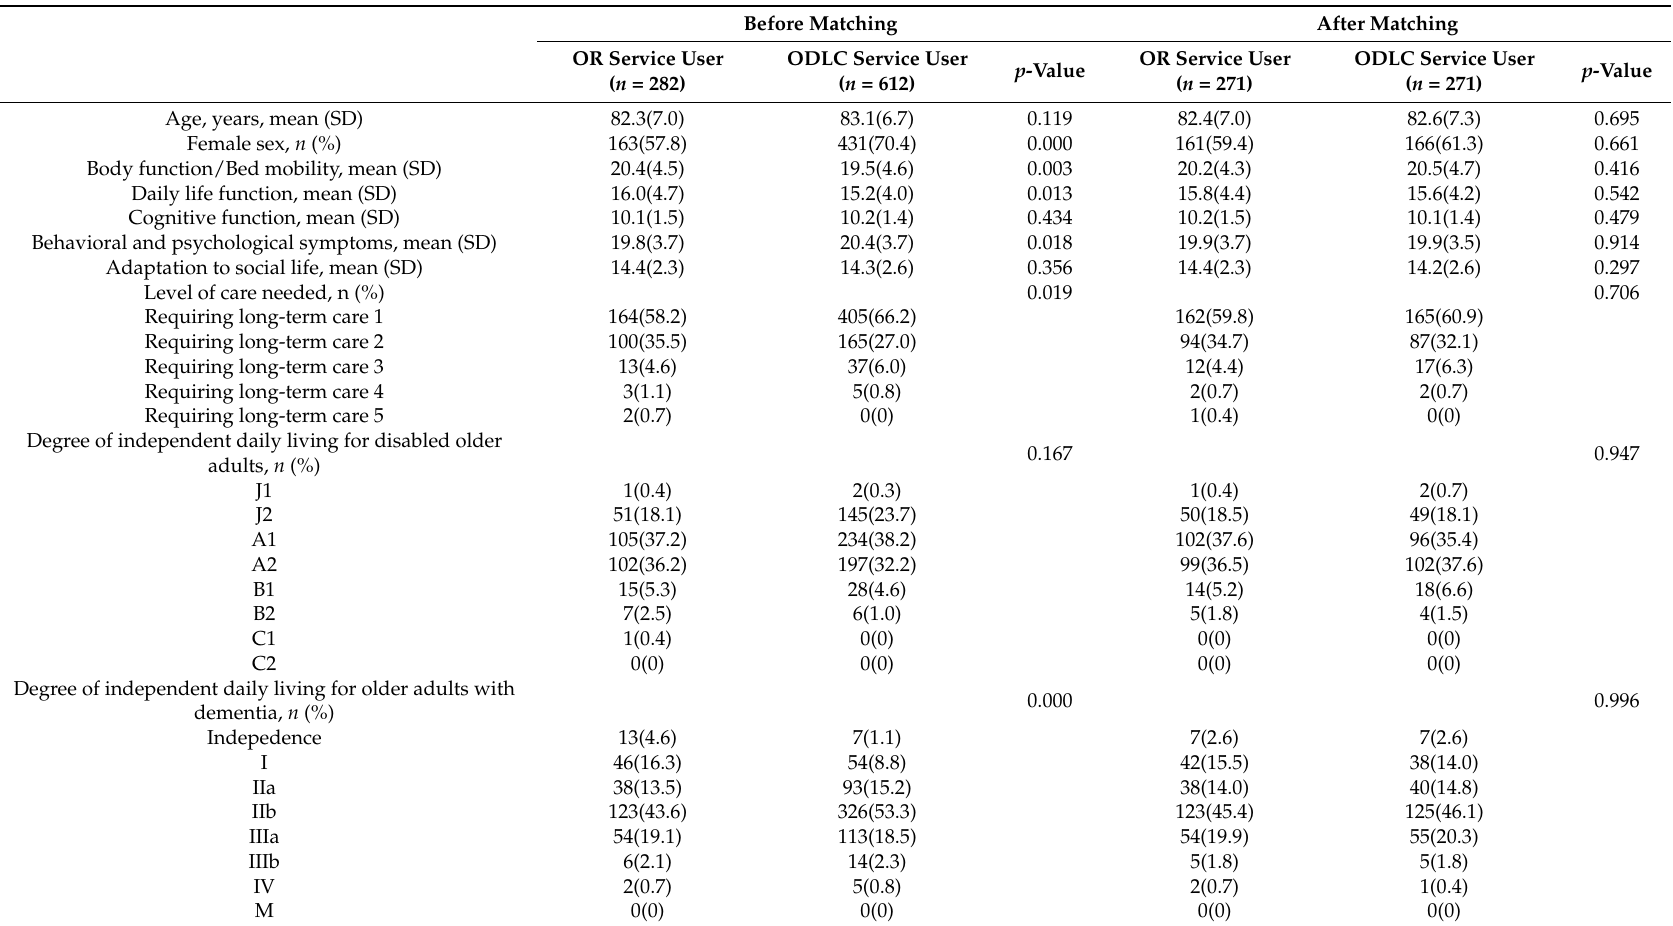
Table 3. Sample characteristics before and after propensity score matching in older adults requiring long-term